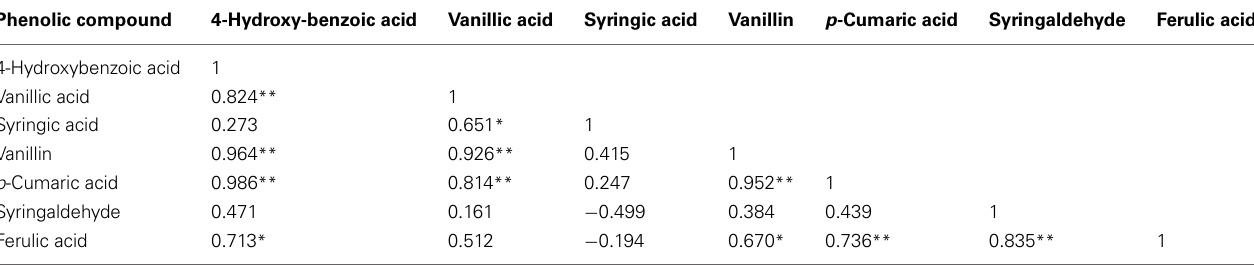
Table 2 | Correlation coefficients among the seven phenolic compounds identified in the rhizosphere soil of wild oat ( n = 11). Phenolic